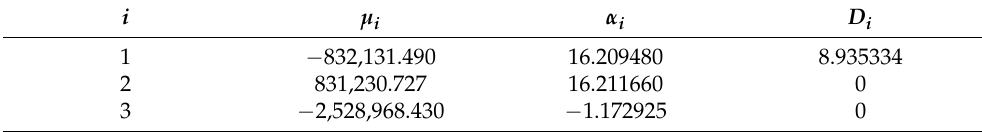
Table 4. Material properties of the specimens modify the coefficients of Ogden’s